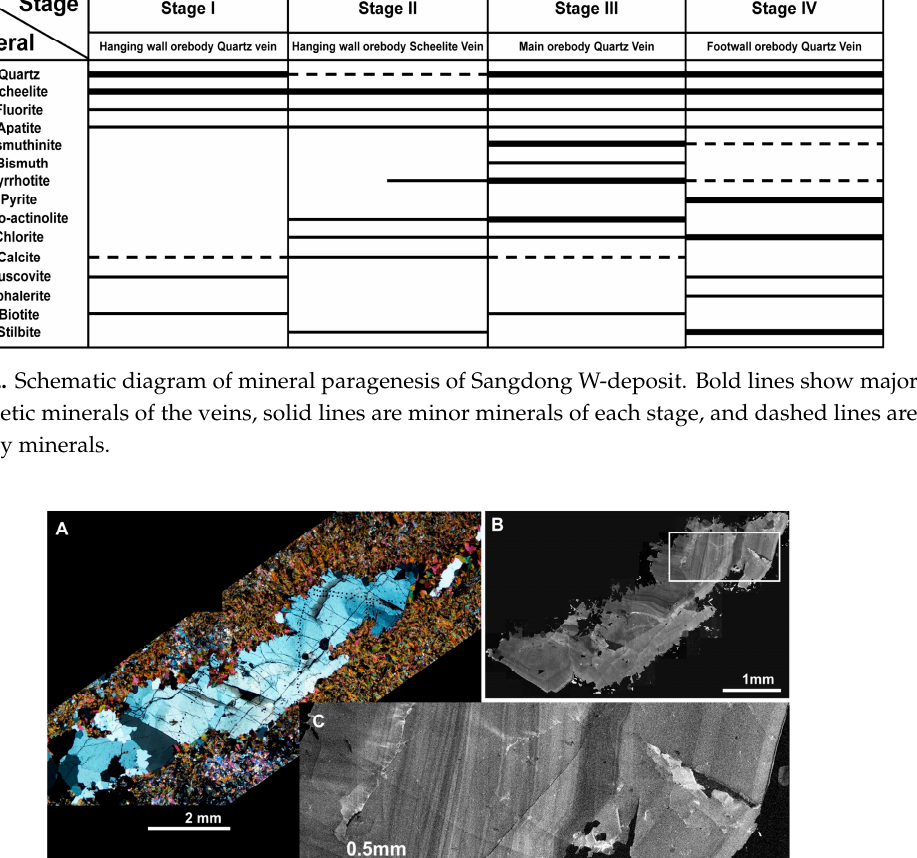
Figure 2. Schematic diagram of mineral paragenesis of Sangdong W-deposit. Bold lines show major paragenetic minerals of the veins, solid lines are minor minerals of each stage, and dashed lines are accessory minerals.